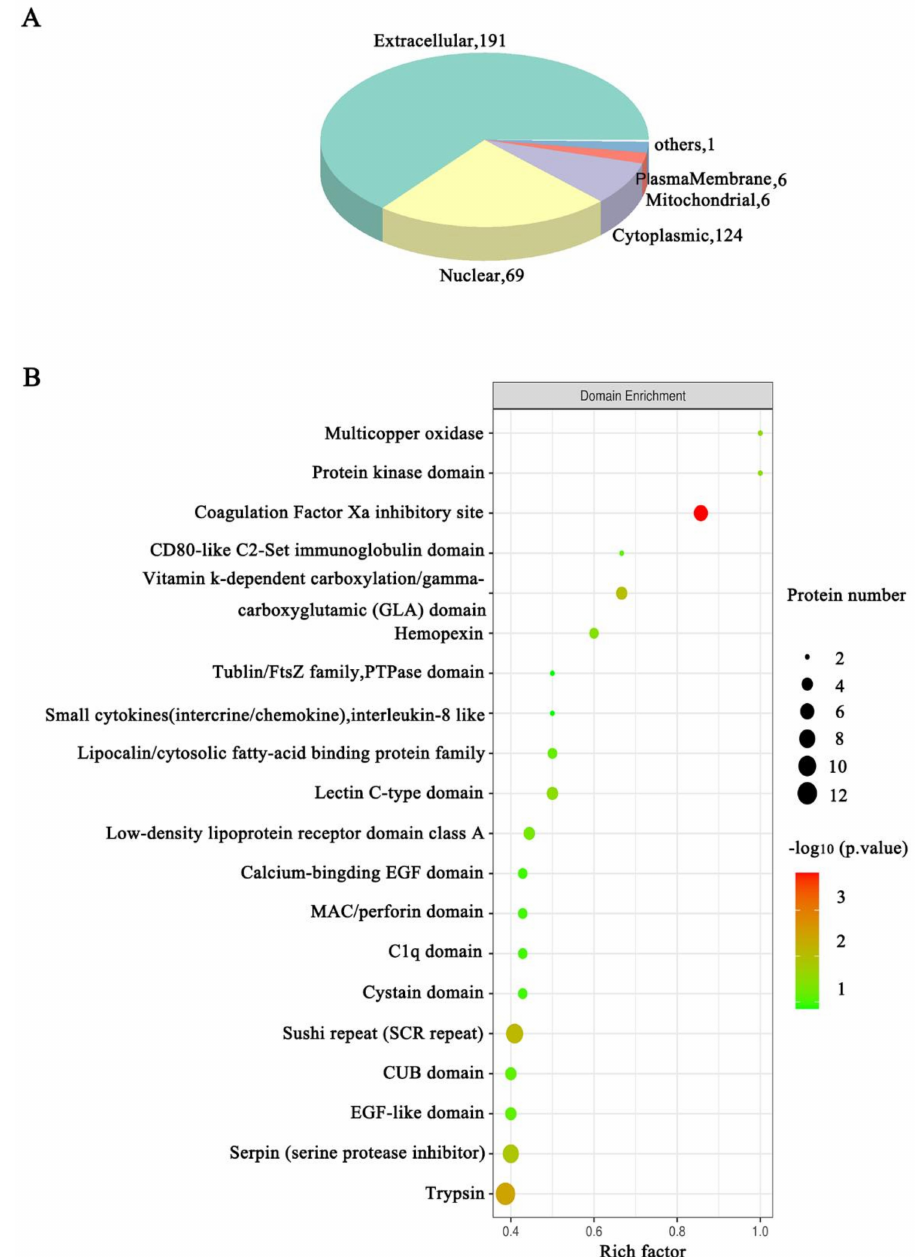
Figure 4. Subcellular localization and domain enrichment analysis of DEPs. ( A ) Pie chart of subcellu- lar localization of DEPs; ( B ) The domain enrichment analysis of